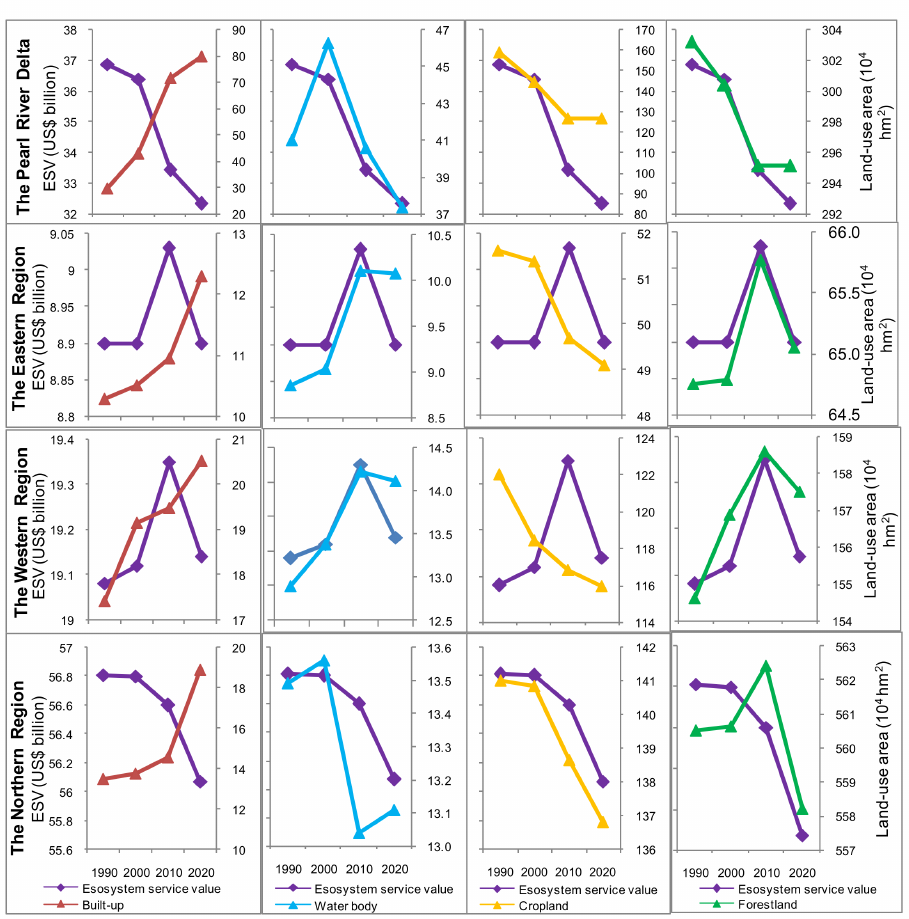
Figure 5. Relationship between total ecosystem service value and Built-Up Area, Cropland, Water Body, and Forestland in the four regions in Guangdong province from 1990 to